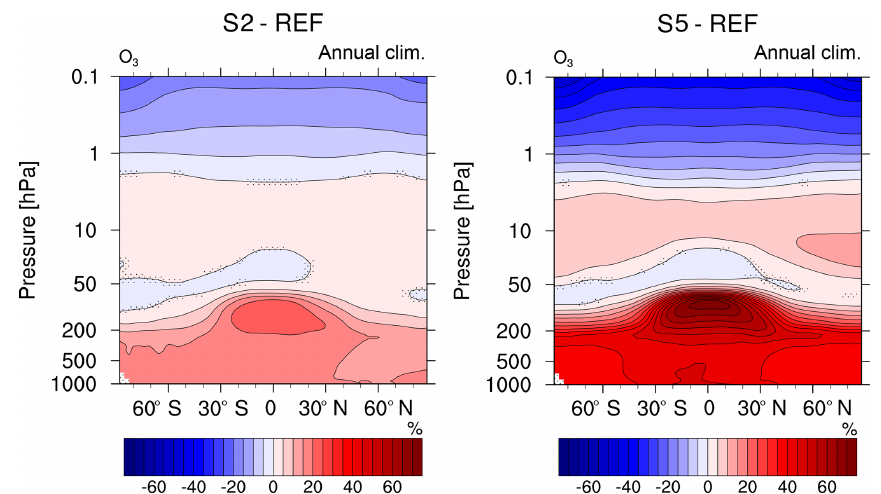
Figure 7. Comparison of the relative changes (%) in annual zonal mean O 3 mixing ratio of the sensitivity simulations S2 and S5 (2- and 5-fold CH 4 , respectively) compared to the reference REF. Non-stippled areas are significant on a 95% confidence level according to a two-sided Welch’s test. Table 1. An estimation of separate RI [in Wm − 2 ] of the changes in the chemical species CH 4 , SWV and O 3 . Values are calculated using the RAD submodel (Dietmüller et al., 2016) in a separate simulation using 20-year climatologies of the individual species. Solely values of the totals are directly calculated from the presented simulations R1, S2 and